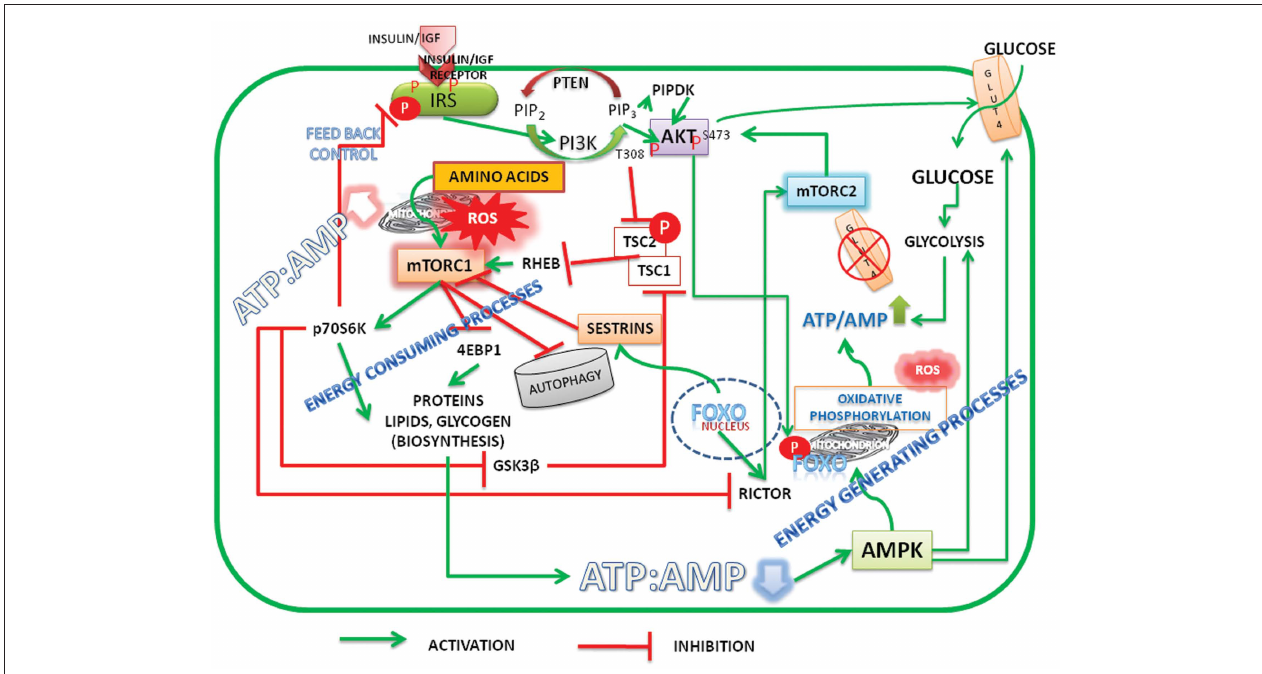
Figure 1 | Schematic representation of energy status of cells modulating cell signaling and mitochondrial function. Under high energy (ATP/AMP ratio)/nutrient levels the insulin/insulin growth factor signaling (IIS) activates PI3K-Akt pathway. Initiation of PI3K-Akt signaling takes place when